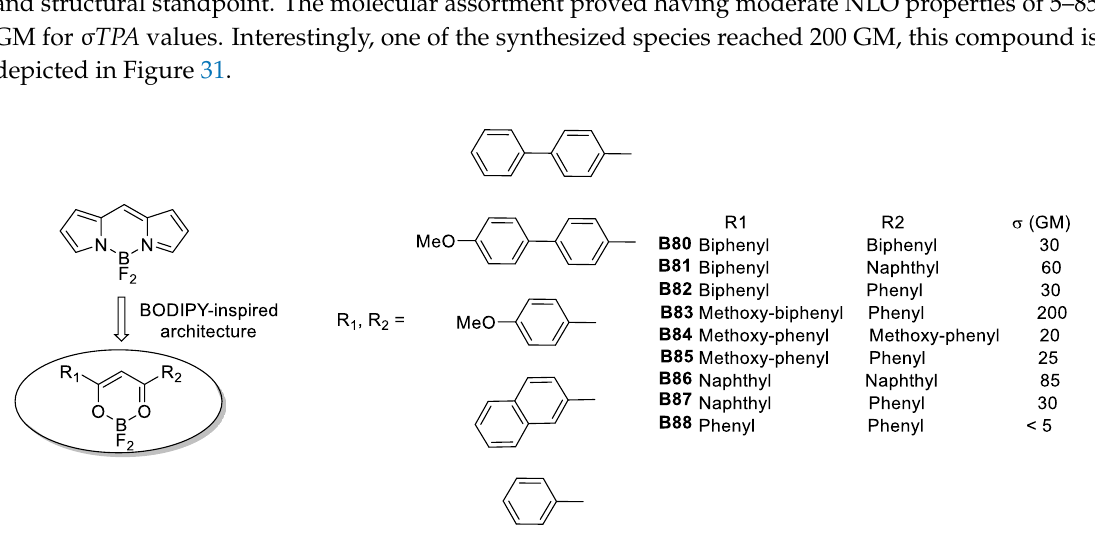
Figure 31. Diaroyl(methanato)boron complexes with aromatic portions as donors studied for their TPA responsiveness.